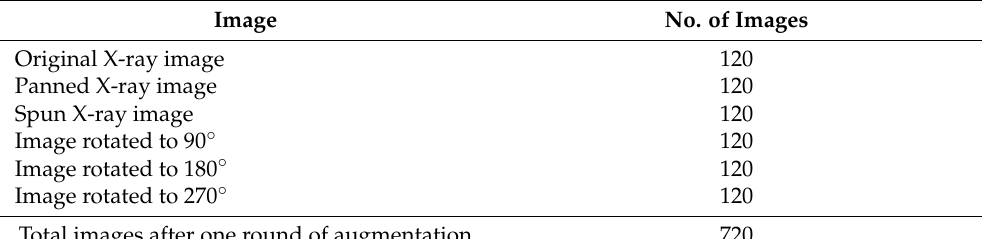
Figure 4. Preprocessed samples of chest X-ray images using the affine augmentation tool. Table 3. Augmented chest x-ray images.